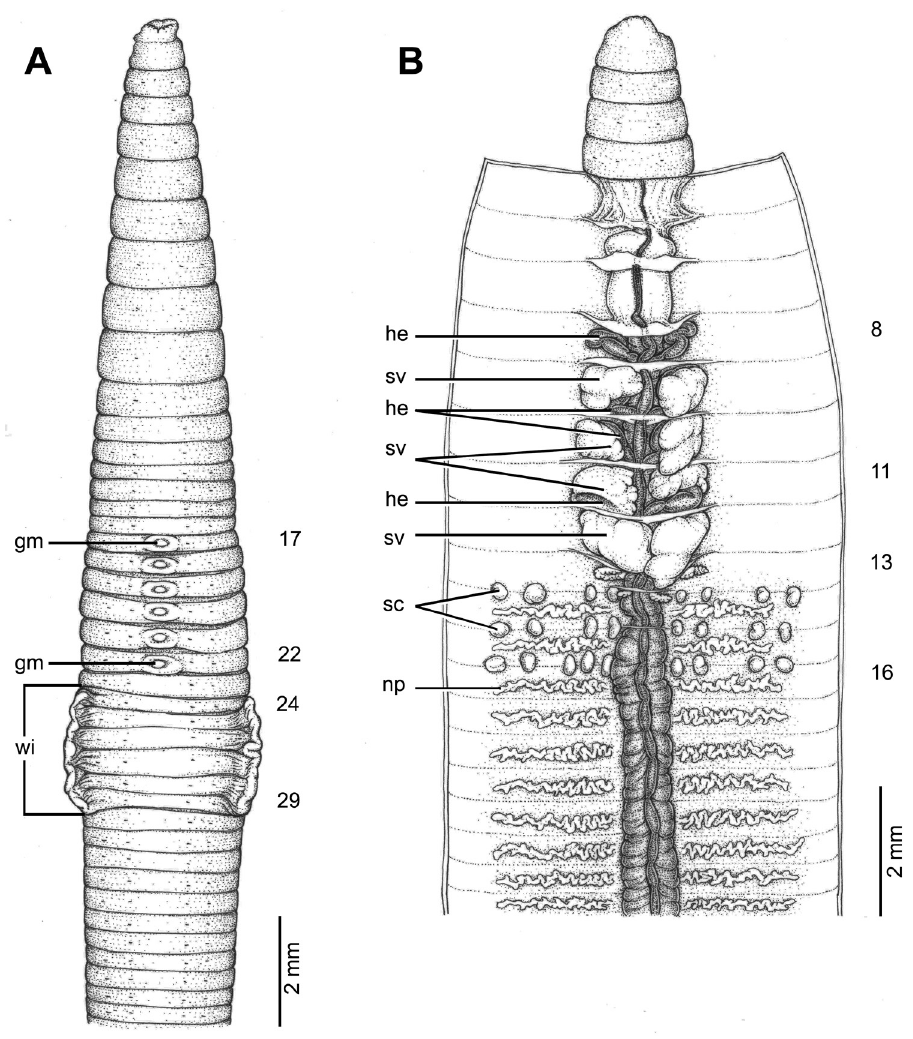
Figure 5. Morphology of holotype (CUMZ 3405) of Glyphidrilus satunensis sp. n. A external ventral view, annular clitellum in XVII–XXXIII B internal dorsal